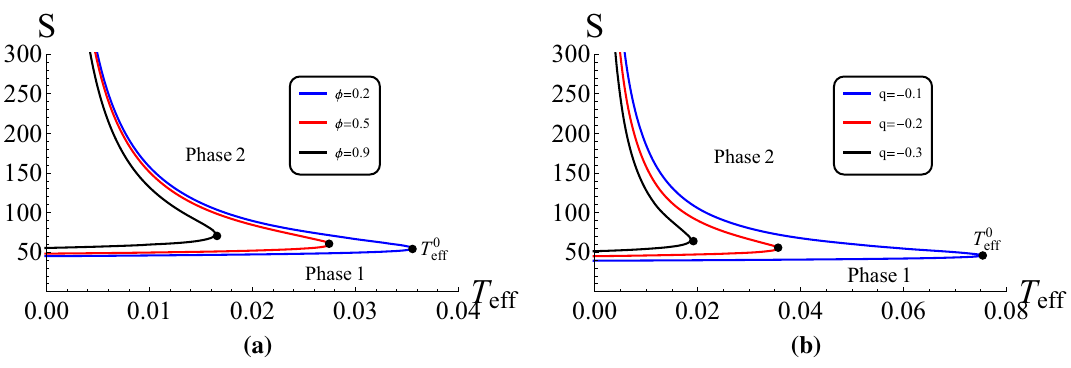
Fig. 7 The same as Fig. 6, but for the behavior of the effective pressure P eff